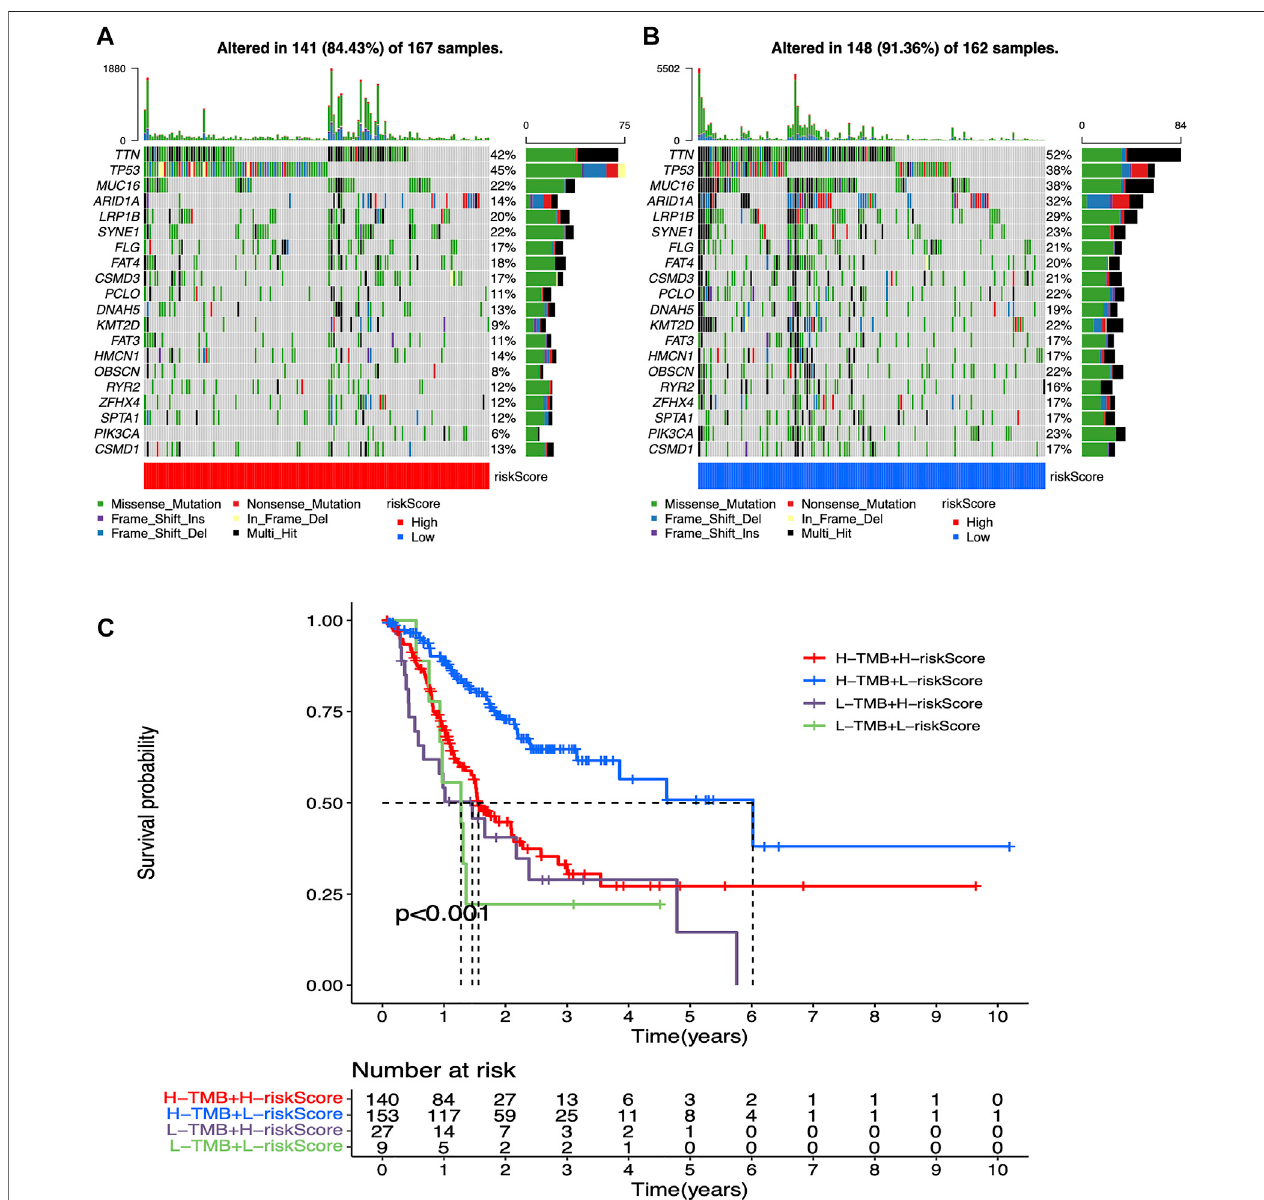
FIGURE5| Mutationanalysisforlow-riskandhigh-riskgroups (A) Mutationwaterfallplotinhigh-riskparticipants.Mutationfrequenciesarerepresentedontheright (B) Mutation waterfall plot in low-risk participants. Mutation frequencies are represented on the right (C) Survival analysis of mutation load combined with risk values.